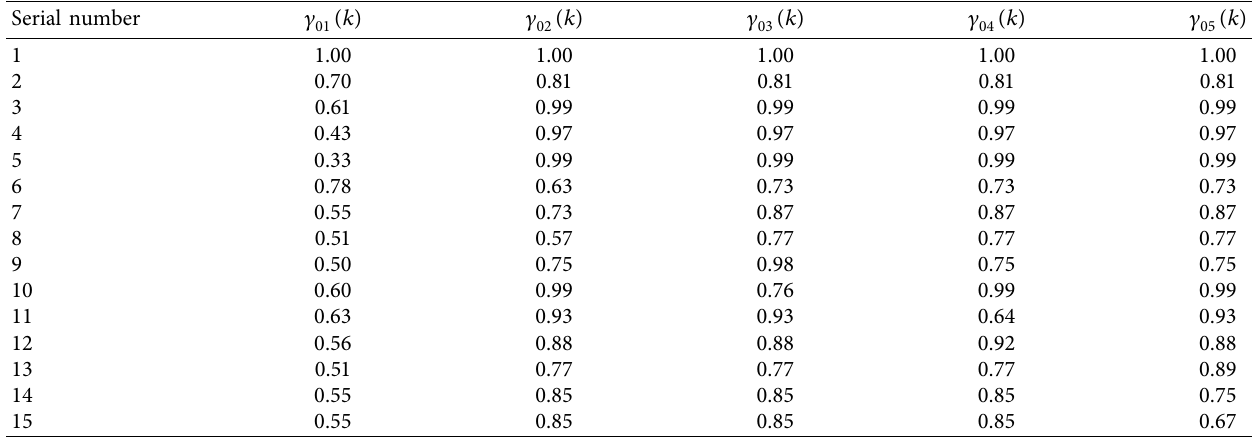
Table 4: Correlation coefficient data of the